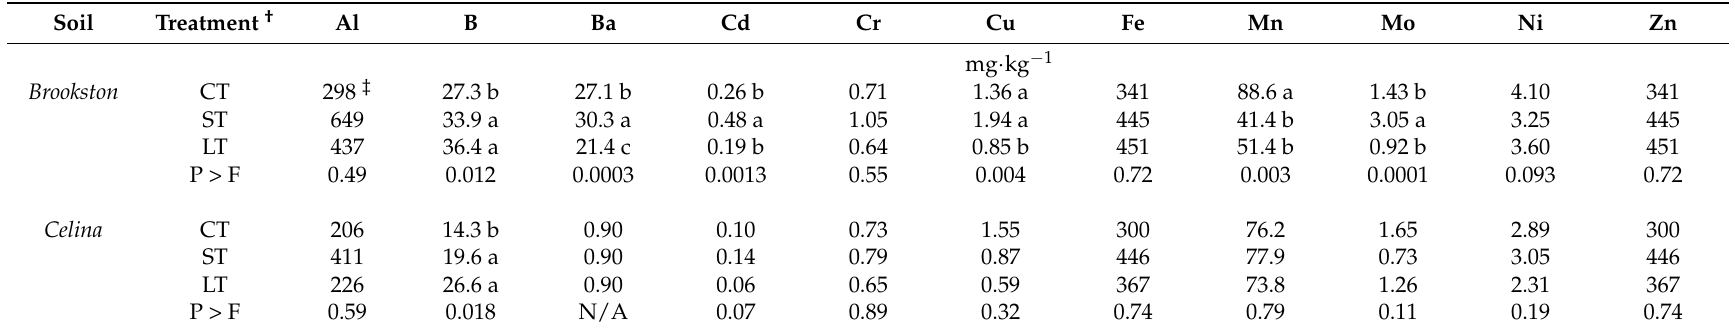
Table 5. Mean concentrations of selected elements (Al, B, Ba, Cd, Cr, Cu, Fe, Mn, Mo, Ni, and Zn) in alfalfa shoots grown in a greenhouse at the end of harvest (180 days after planting) in intact cores of two Ohio soils treated with three levels of